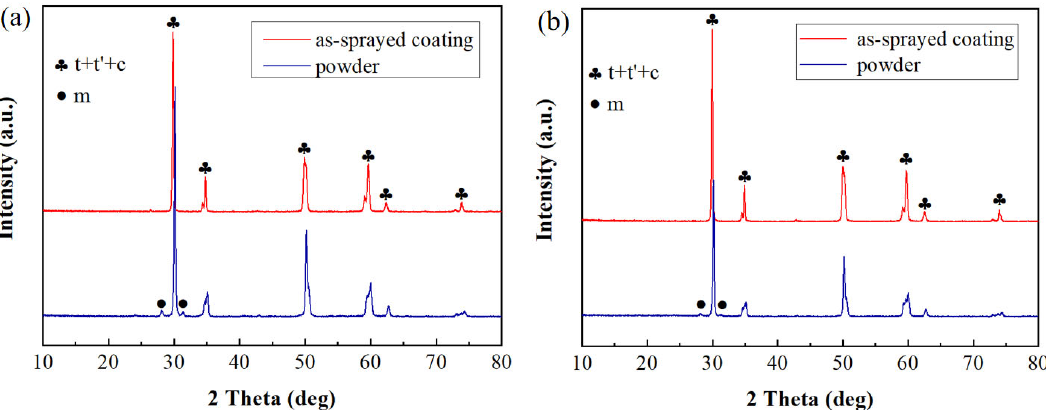
Figure 5. XRD patterns of two kinds of YSZ powder and corresponding coating: ( a ) fine powder; ( b ) coarse powder.